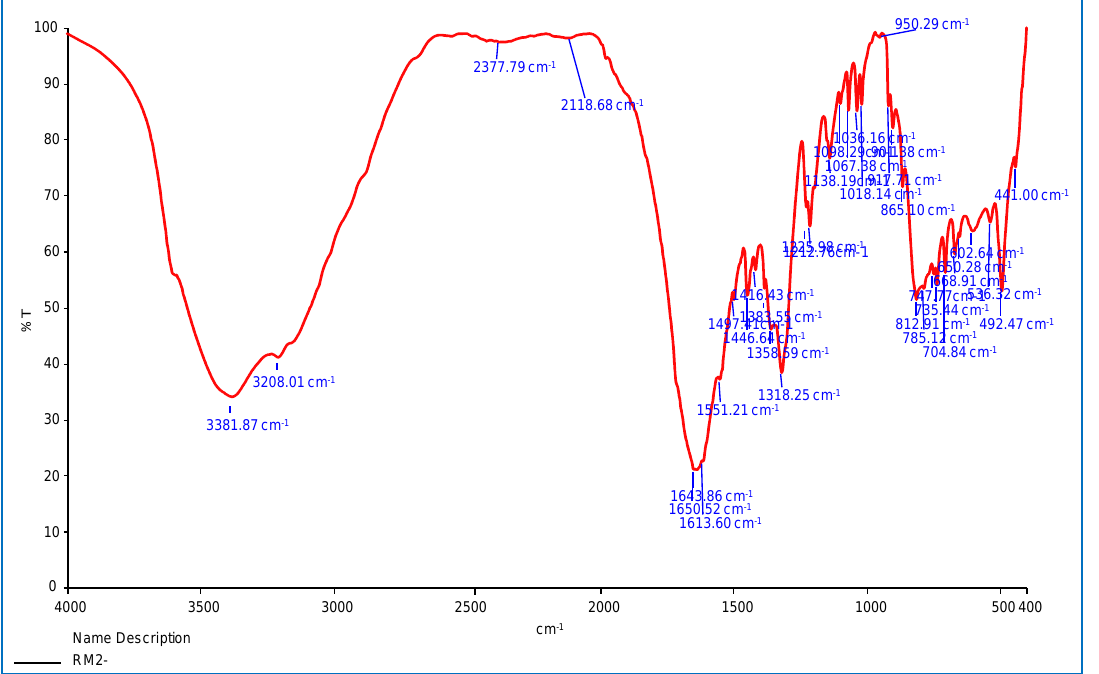
Figure 5. FTIR spectrum of Ni(II) mixed ligands complex. The v(C=O) stretching vibrations of INH reveal a band at 1643 cm − 1 for Ni(II) com-